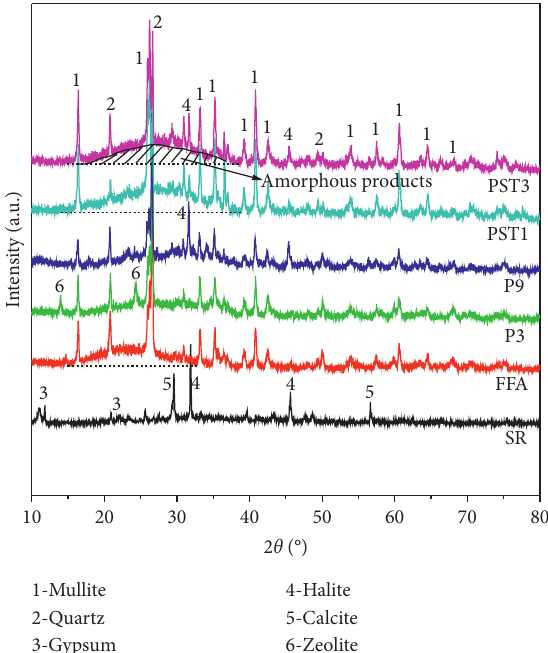
Figure 5: The XRD patterns of sample PST3 and controls (PST1, P3, and P9).